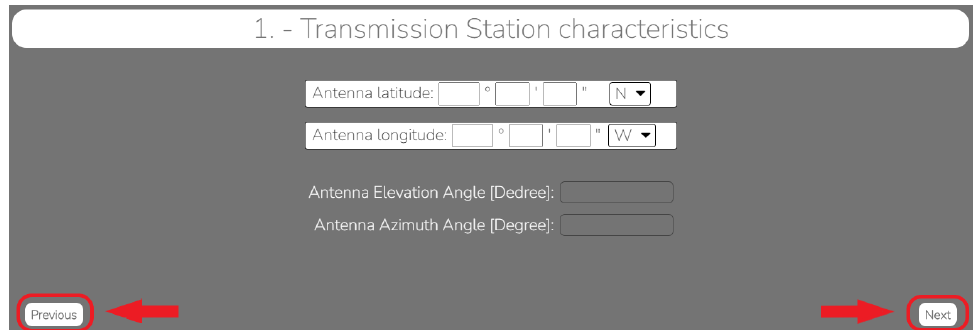
Figure 16. Satellite project link budget step